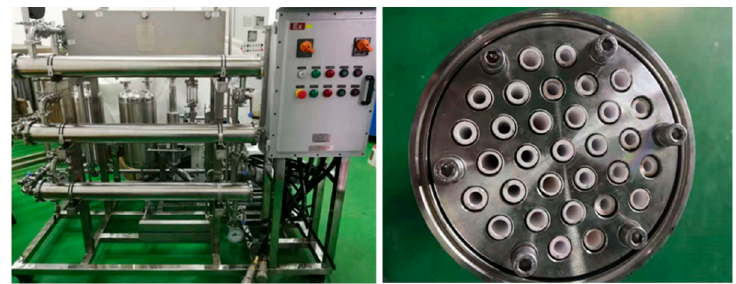
Figure 11. Pilot-scale equipment and membrane module. Table 5. Parameters of the wastewater